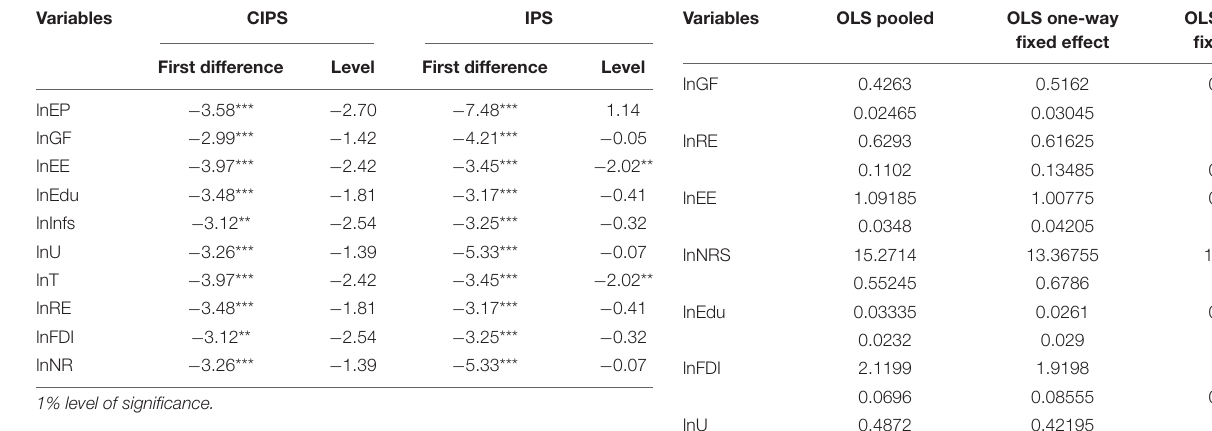
TABLE 3 | Results of unit root test. TABLE 4 | OLS regression